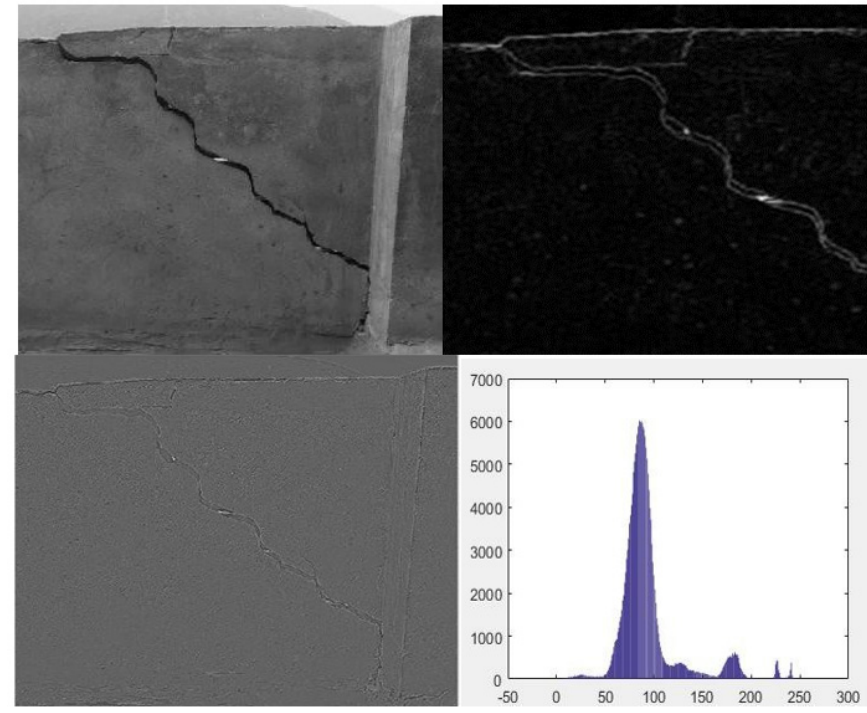
Figure 10. Different forms of crack identification characteristics (Original image, Sobel algorithm, Prewitt algorithm).